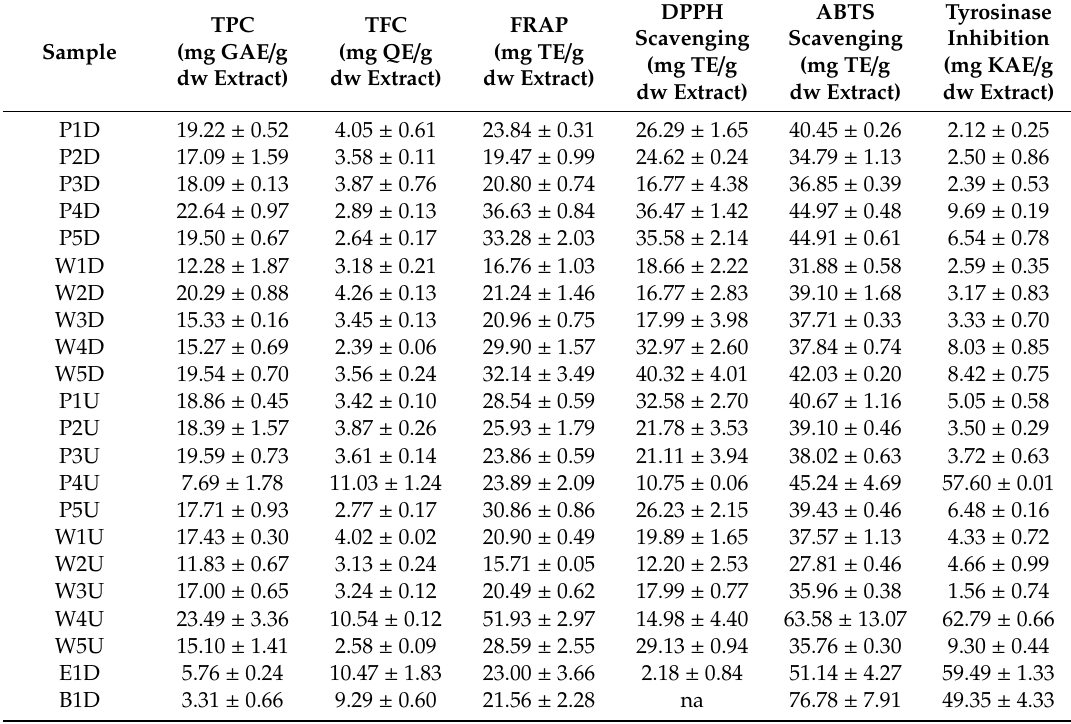
Total phenolic (TPC) and flavonoid (TFC) content, 2,2-diphenyl-1-picryl-hydrazyl (DPPH), 2,2 (cid:48) -azino-bis-(3-ethylbenzothiazoline-6-sulfonate (ABTS) scavenging capacity, ferric reducing antioxidant power (FRAP), and tyrosinase inhibition of the extracts of Lycium cultivars (values expressed are means ± SD of three